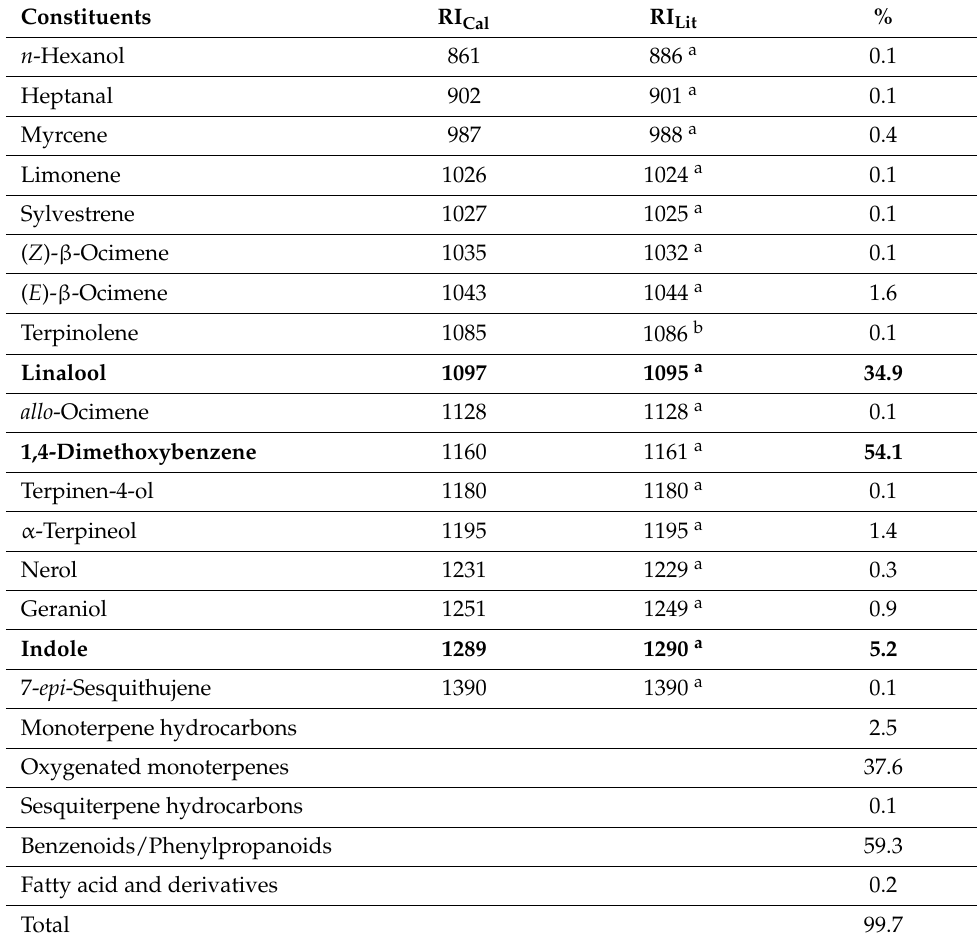
Table 5. Constituents identified in the volatile concentrate of C. galeritum